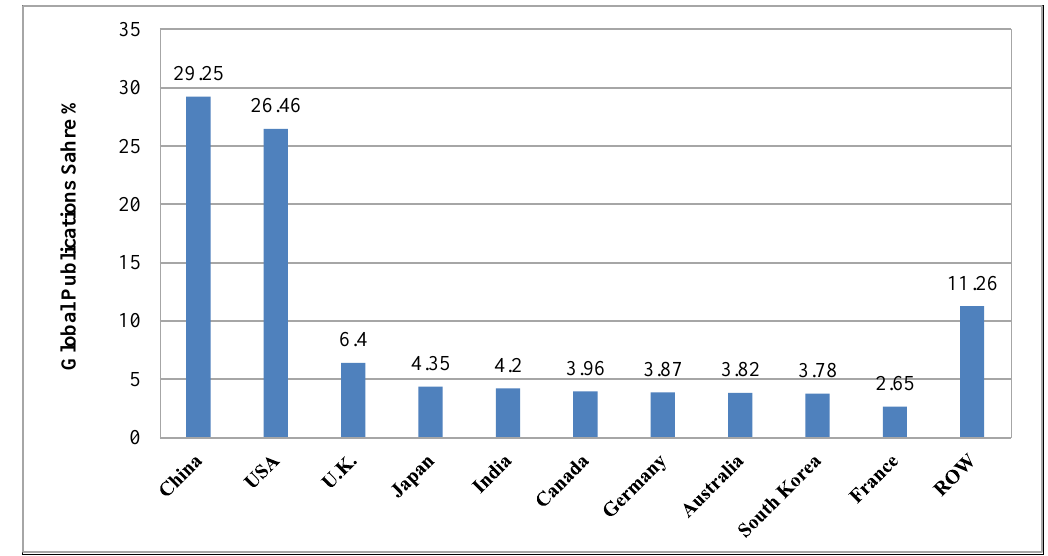
Figure 2. Deep Learning Research: Most Productive Countries in the World 2004-17